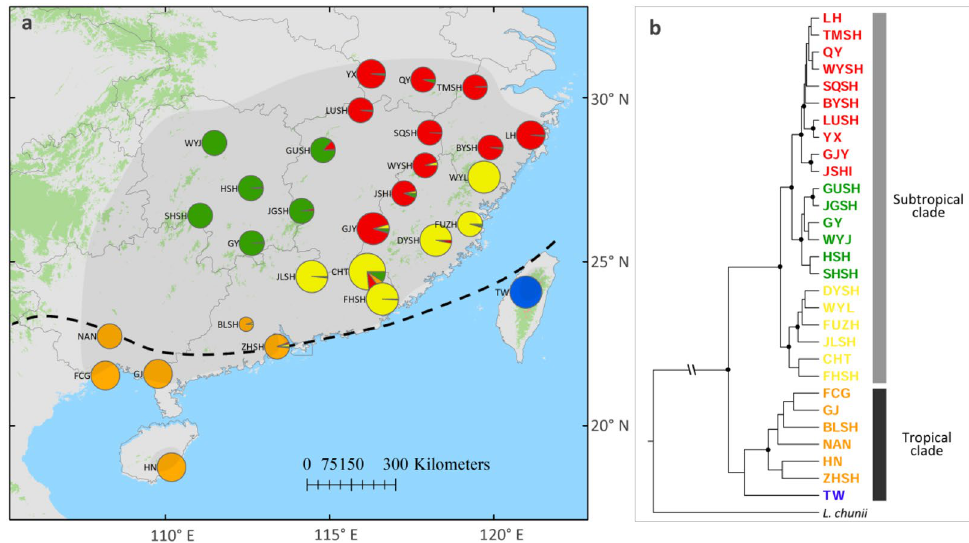
Figure 1. ( a ) Colour-coded grouping of the 29 Lindera aggregata populations according to STRU CTU RE with the most likely group number K = 5 (ArcGis 10.2, ESRI, www.esri.com), the dashed black line represents the boundary of subtropical (Sino-Japanese Floristic Region) and tropical (Paleotropic Floristic Region) regions. The shaded area indicates the species’ distribution range. ( b ) BEAST-derived phylogeny for the 29 populations. The colour of populations indicates their genetic cluster as inferred by STRU CTU RE. Statistically significant posterior probabilities (PP > 0.95) are labeled in black